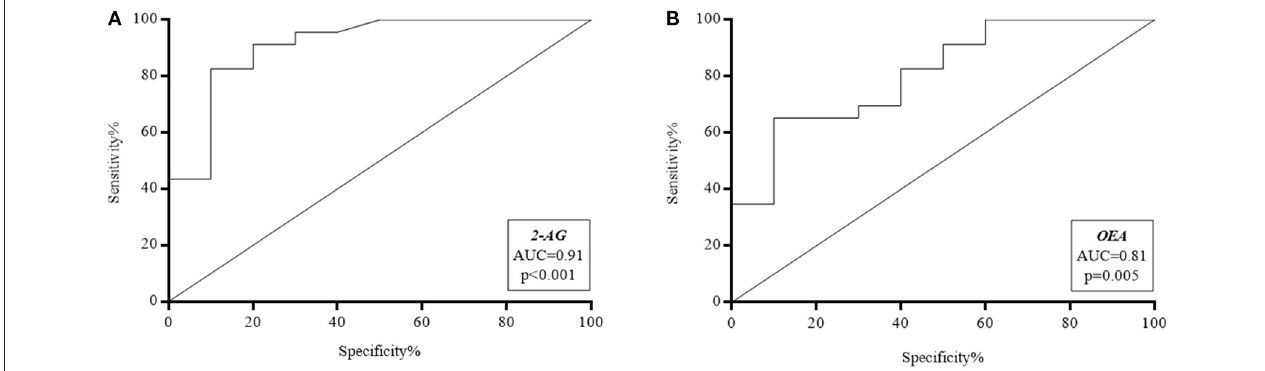
FIGURE 4 | Receiver operating characteristic (ROC) curves of (A) 2-arachidonoylglycerol (2-AG) and (B) N-oleoylethanolamine (OEA). AUC, Area Under